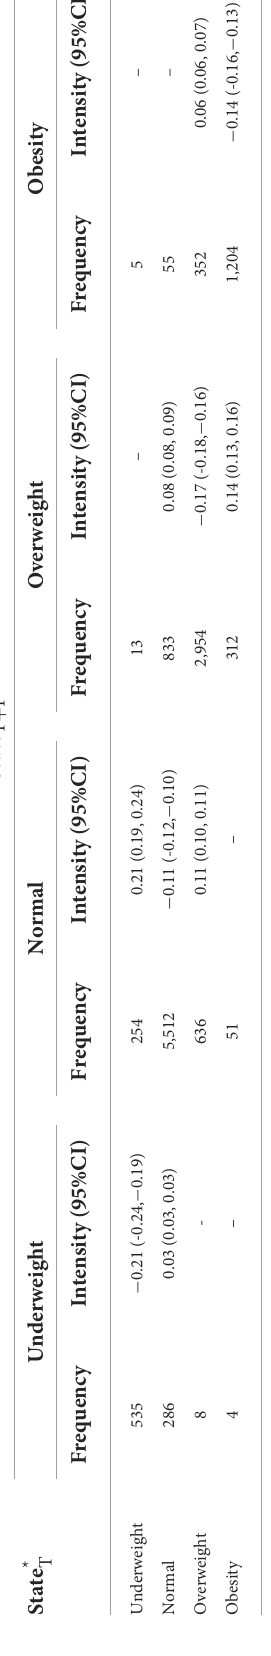
compared with the non-smokers. Participants with